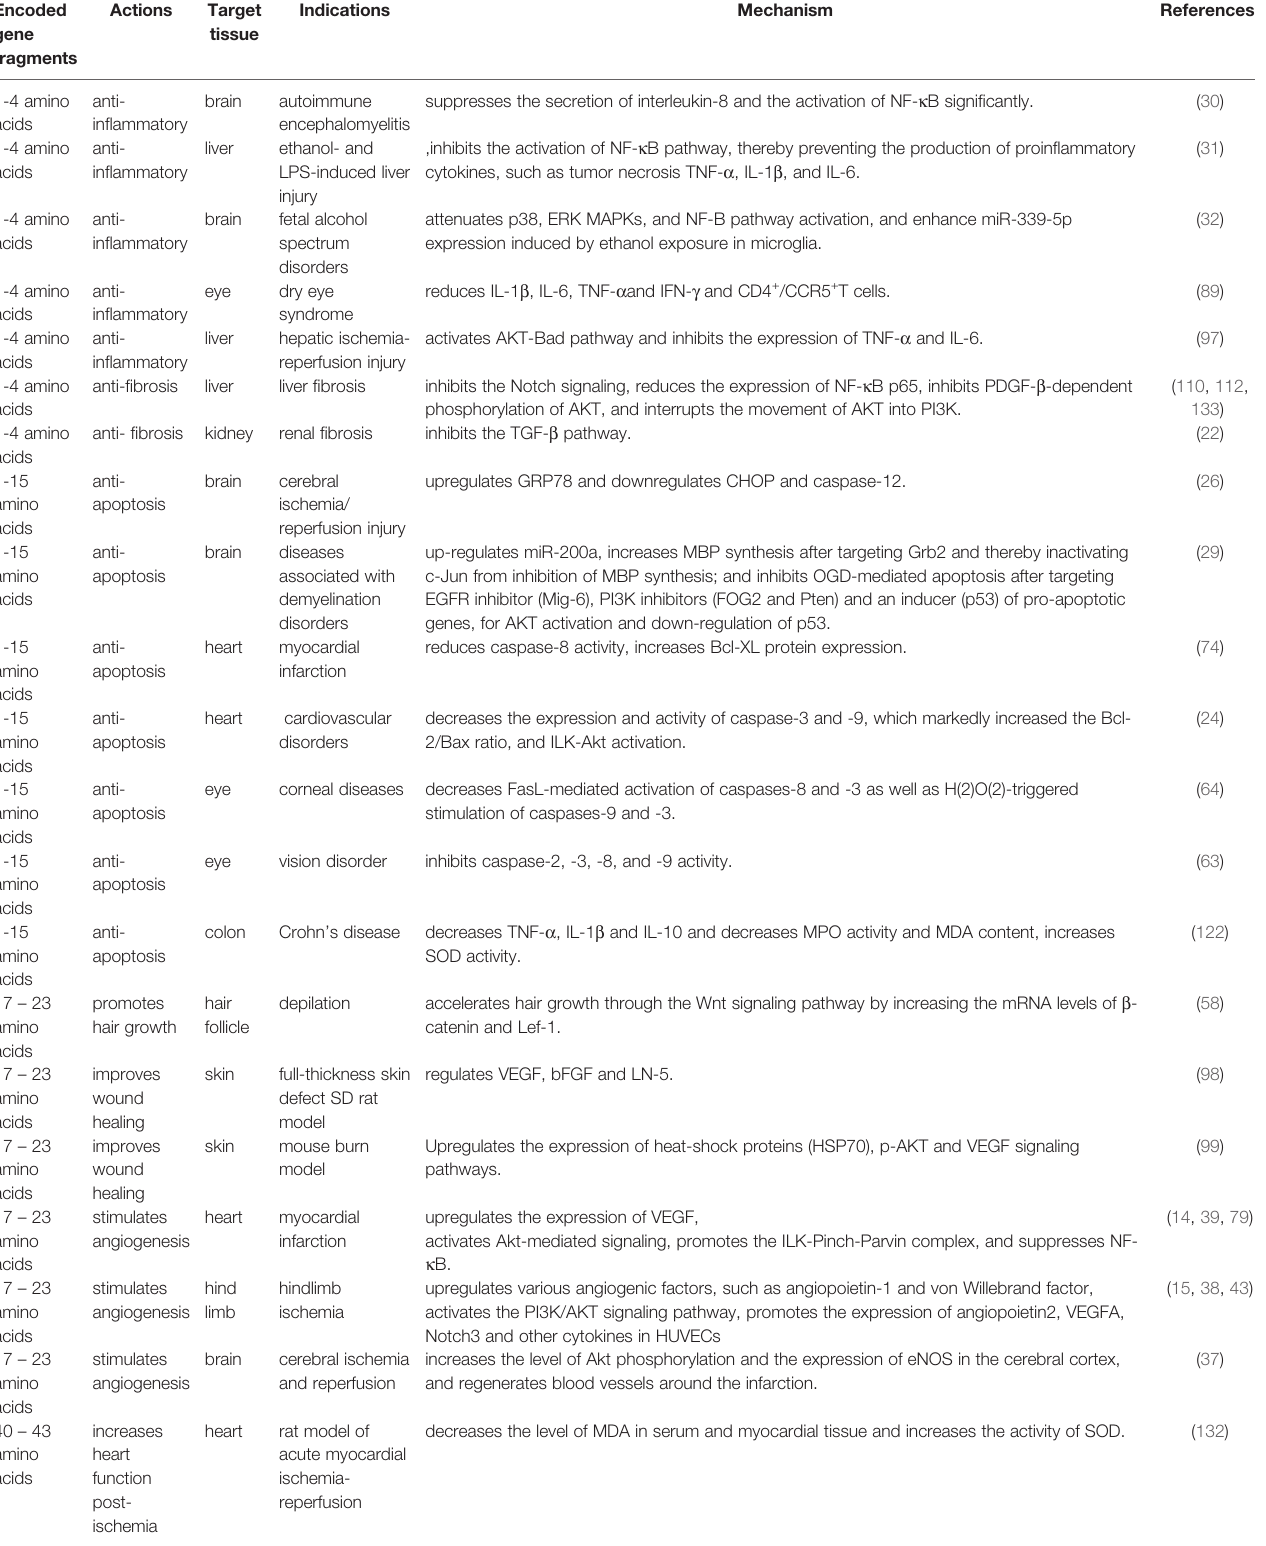
TABLE 1 | Actions of T b 4 and